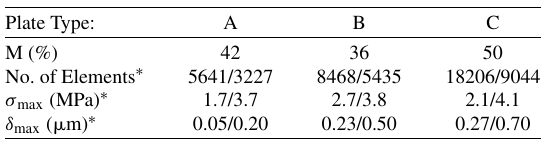
Table 1 Number of elements and nodes used in the plate